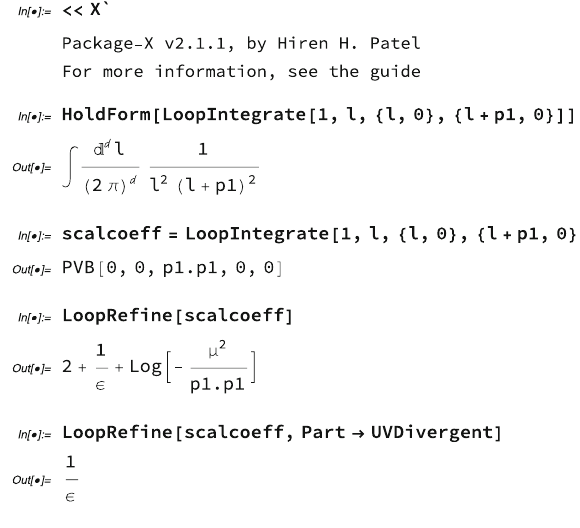
Fig. 6 Loading Package-X in Mathematica andextractingtheUVpole of the scalar two-point